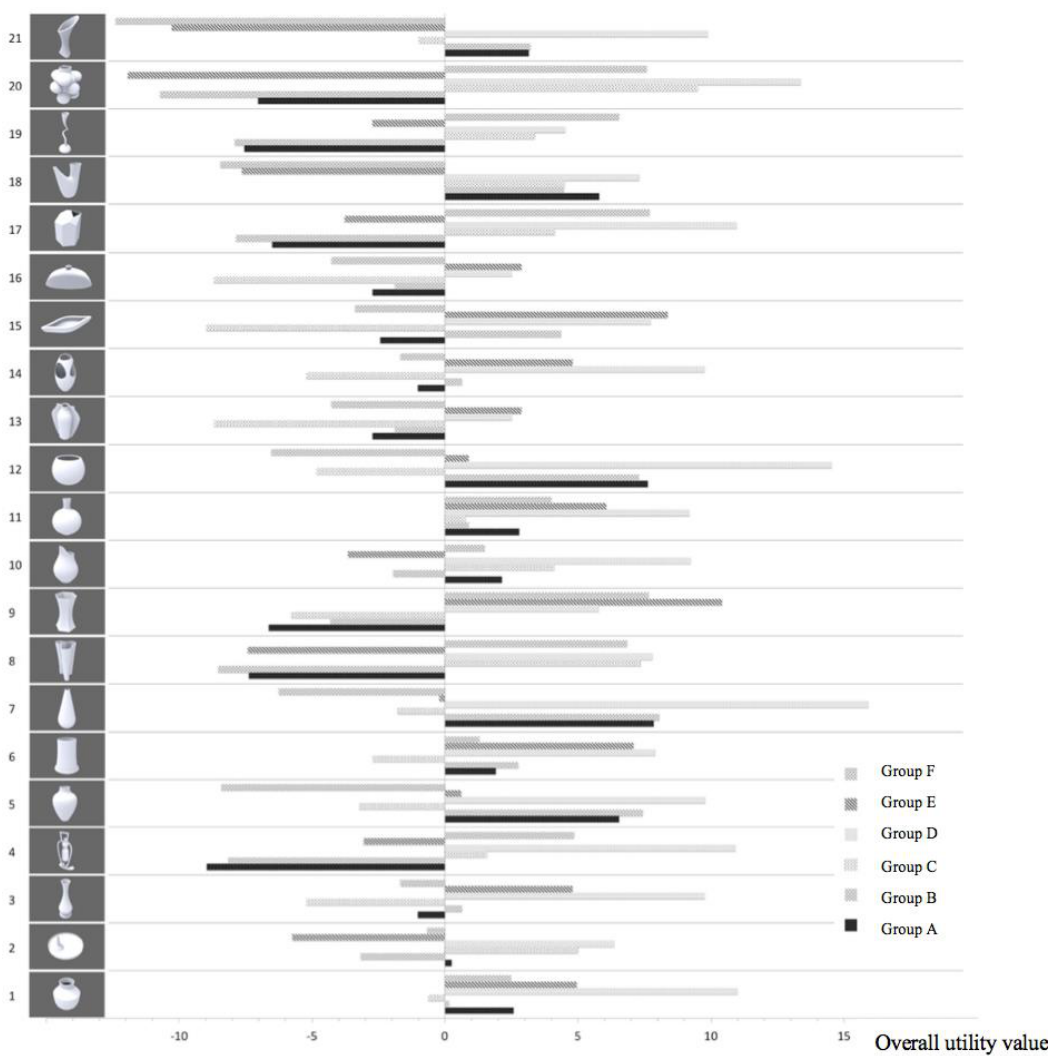
Figure 11. The overall utility values of six groups toward 21 vase forms.